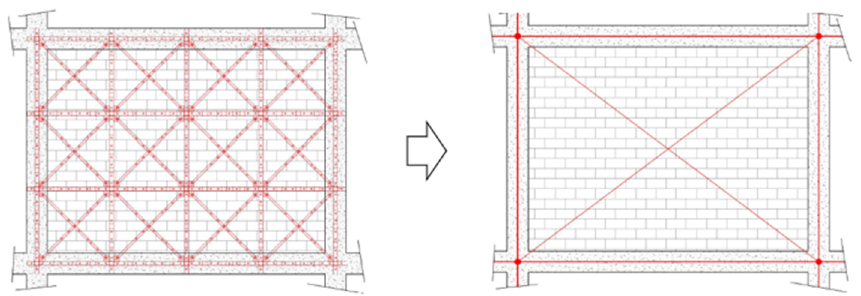
Figure 13. Illustrative diagram of the modelling approach for braces of the Resisto 5.9 system.